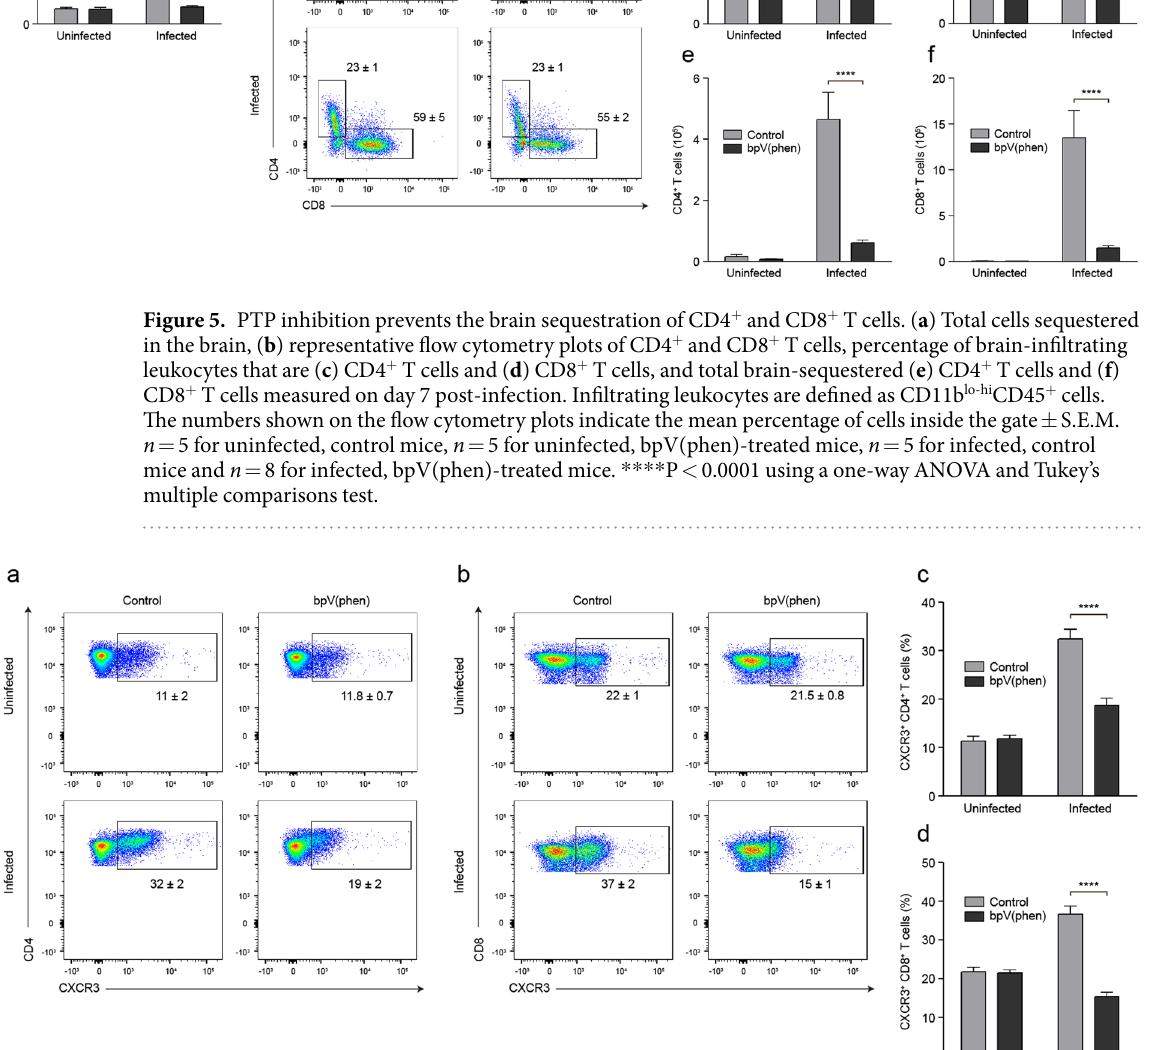
by measuring the percentage of CD8 + T cells that were CD11a hi CD8 lo at the onset of symptoms in the control mice 38 . bpV(phen) did not affect the frequency or total number of antigen-experienced CD8 + T cells induced by P. berghei ANKA infection (see Supplementary Fig. S6). Thus downregulation of CXCR3 expression on both CD4 + and CD8 + T cells, and the consequent attenuation of T cell chemotaxis to the brain, rather than decreased numbers of responding T cells, appears to be the main mechanism through which PTP inhibition prevents neuropathogenesis.